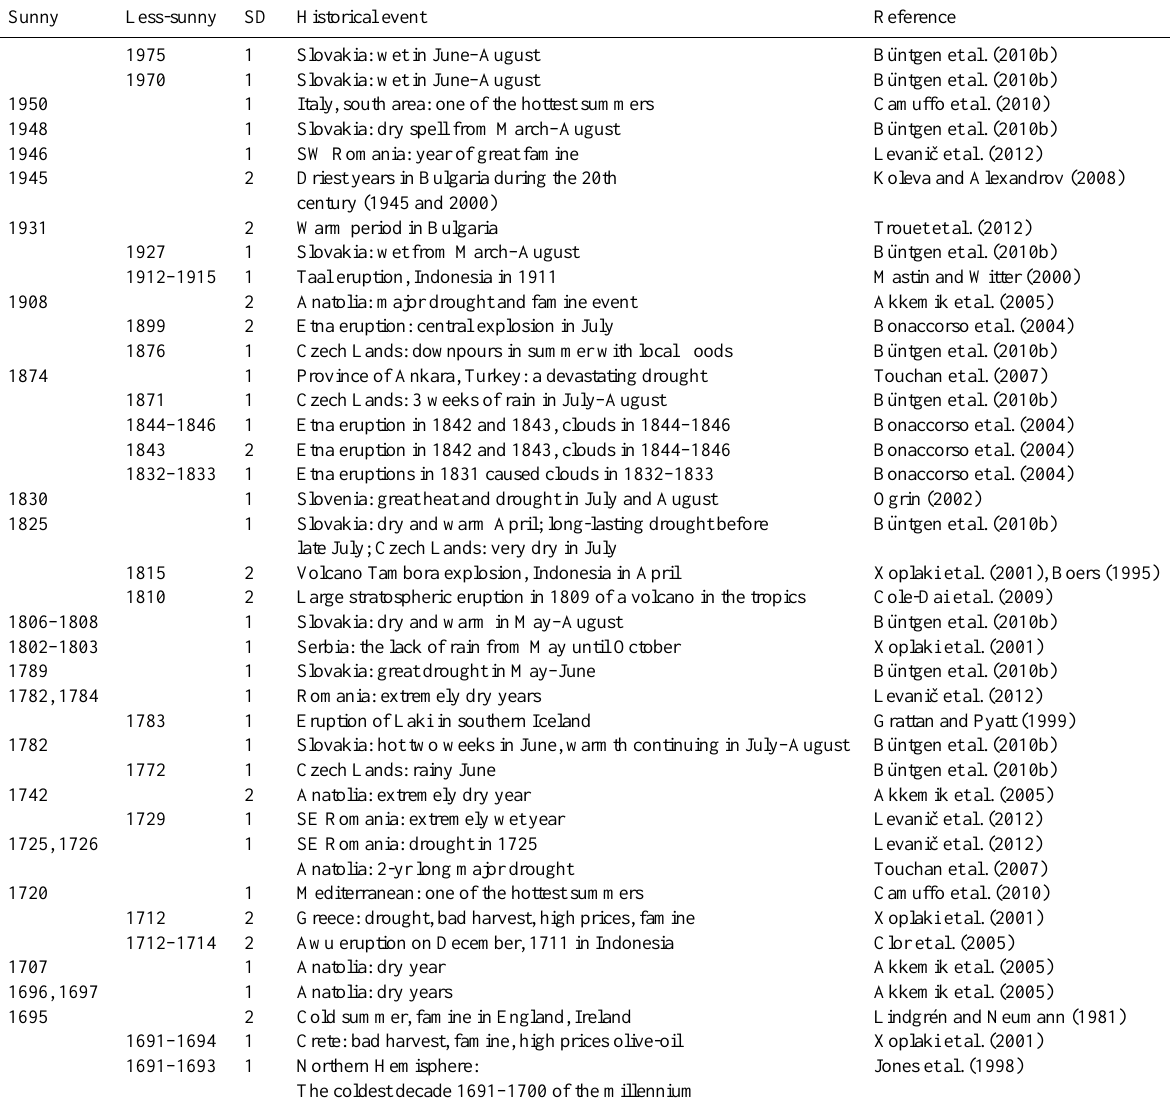
Table 5. Records of reconstructed sunny/less-sunny summers based on TRW from BiH, with standard deviations (SD) and their comparison with other related available documentary